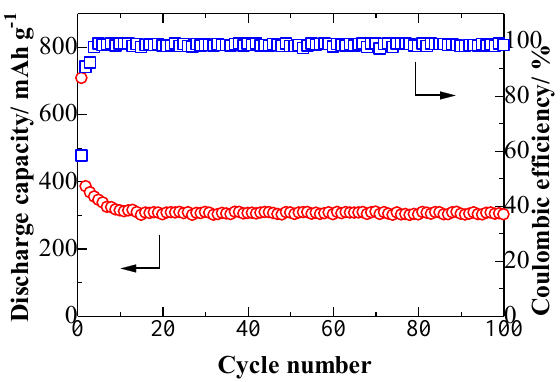
Figure 10. Cycling performance and coulombic efficiency of the C@Fe 2 O 3 composites.